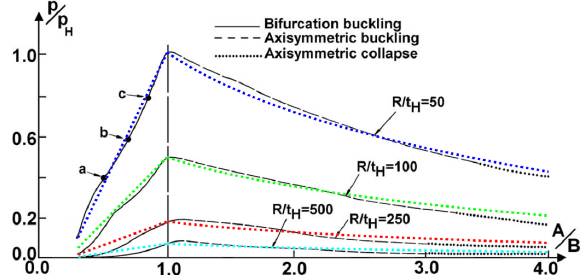
Figure 16. Elastoplastic buckling loads for different thickness ratios of the reference hemisphere [43] (AR =